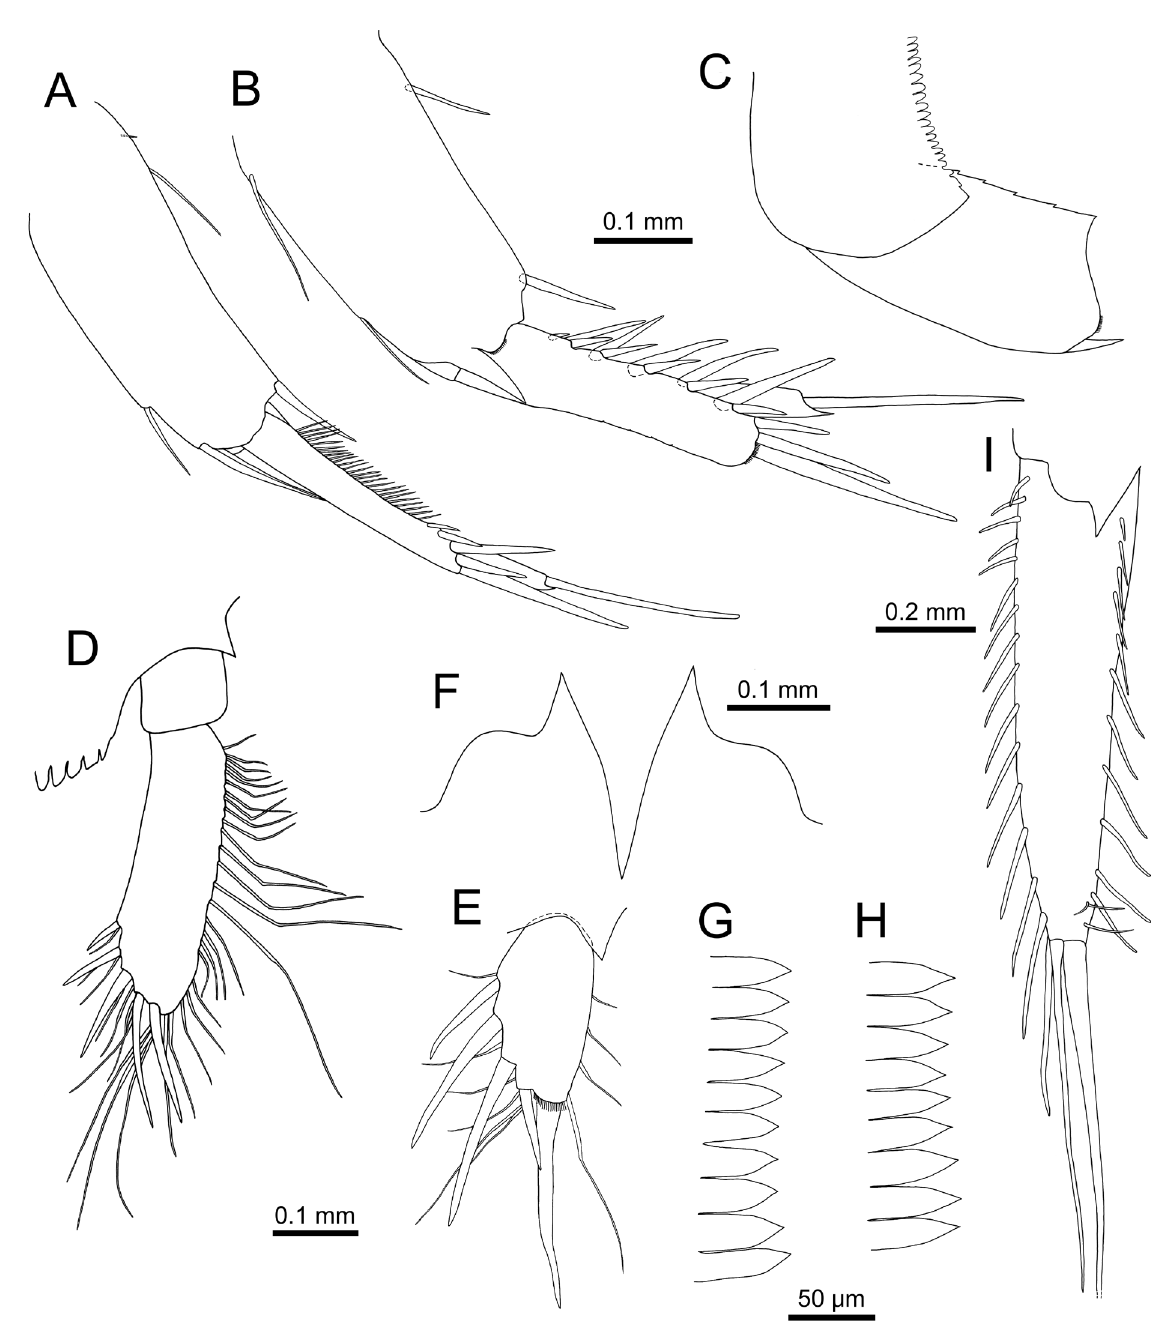
Fig. 4. Nebalia strausi Risso, 1826. Preovigerous female (DBUA0001677.01.W). A . Pleopod I, lateral view. B . Pleopod II, lateral view. C . Pleonite IV, epimeron and pleopod IV protopod, lateral view. D . Pleopod V, ventral view. E . Pleopod VI, ventral view. F . Anal plates, ventral view. G . Pleonite VI, posterior dorsal and laterodorsal border, denticles. H . Pleonite VII, posterior dorsal and laterodorsal border, denticles. I . Right uropod and anal plate, ventral view. A–C, D–E, G–H: same scale bars; A–B, I: plumose setae not